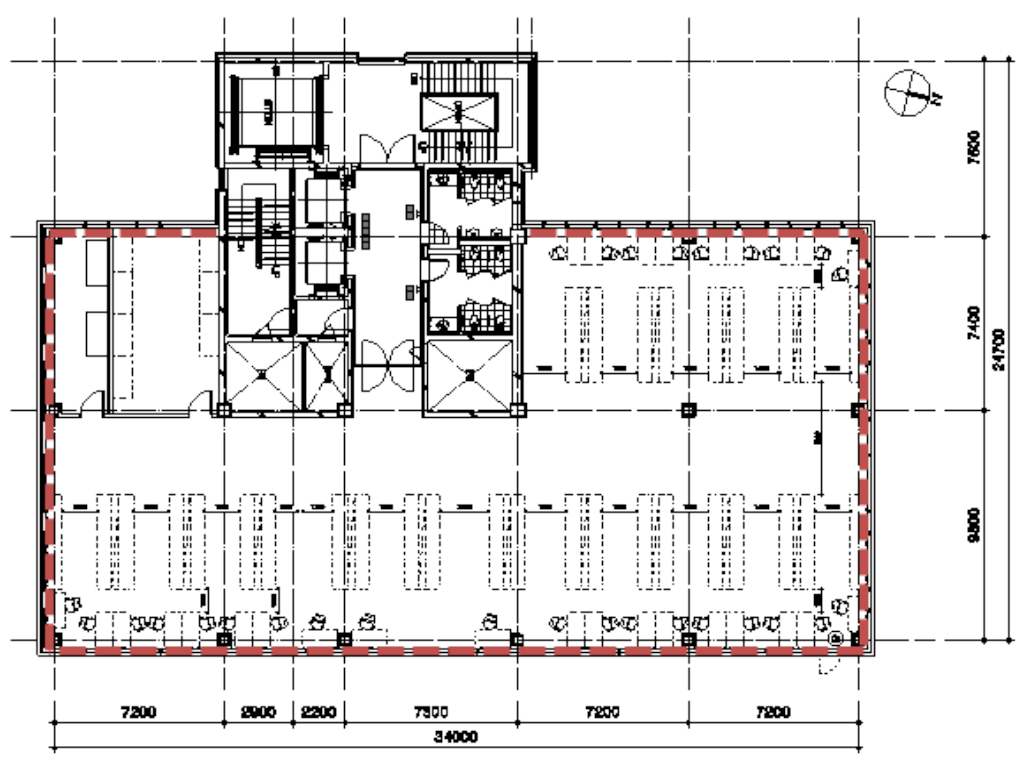
Figure 3. Typical floor plan of the studied